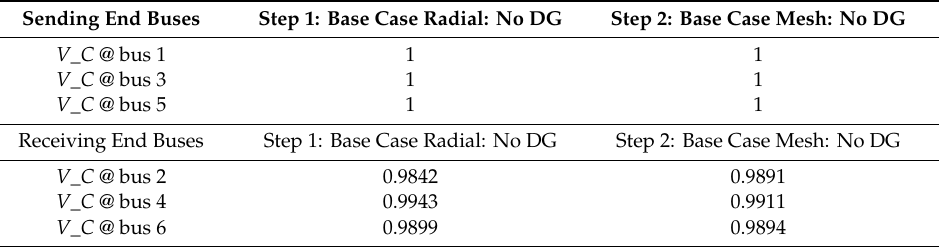
Table A2. Steps 1–4 of the computation